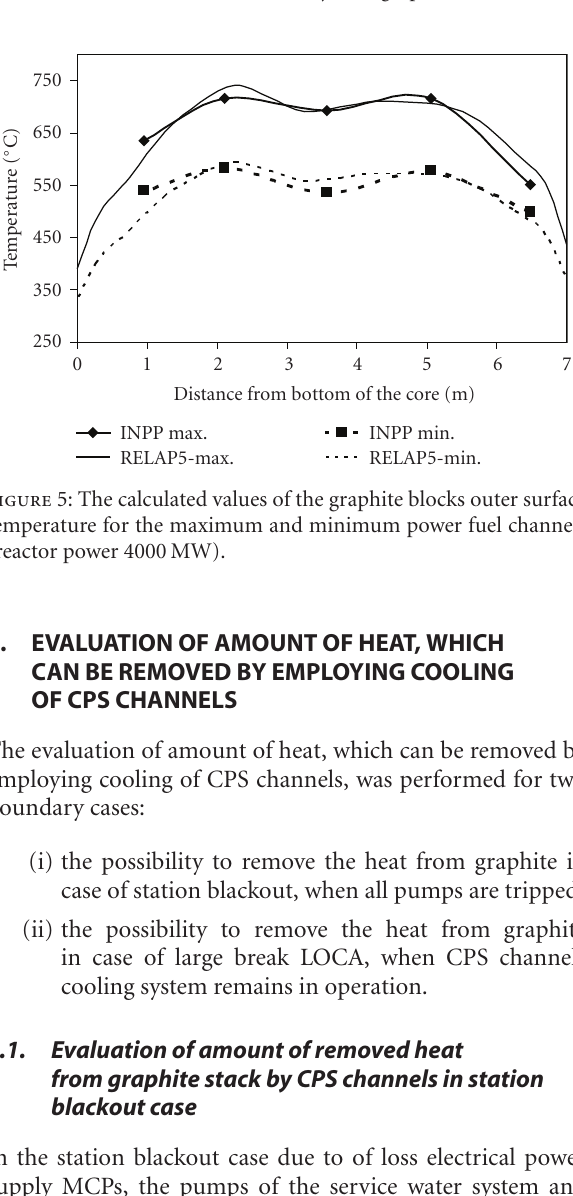
Figure 4: Schematic of two adjacent graphite blocks.